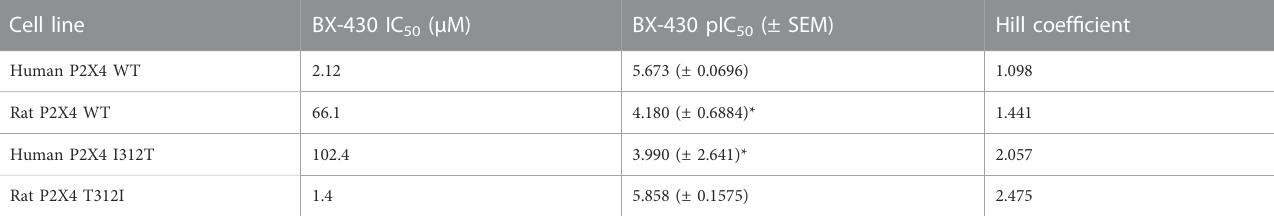
TABLE3BX430IC 50 valuesforwildtypeandmutantratandhumanP2X4receptors.SEM,standarderrorofthemean.*indicates valuessigni fi cantlydifferenttohuman P2X4 wild type (WT) ( p ≤